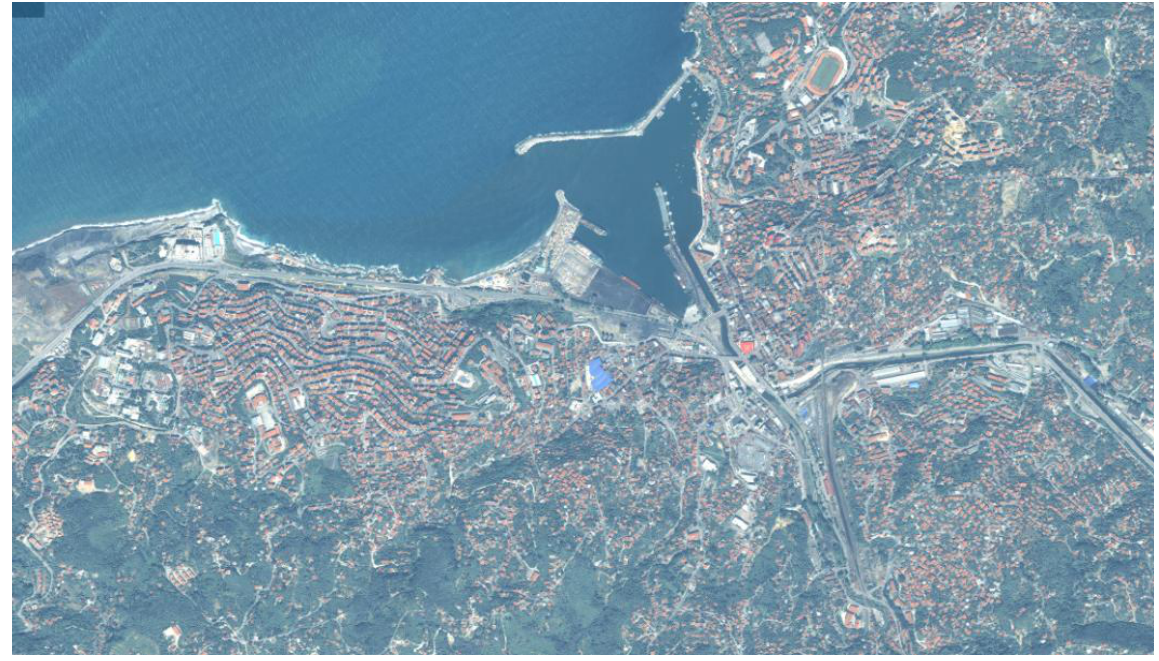
Figure 2. Subset of Pan-sharpened IKONOS-2008 Image of Zonguldak Study